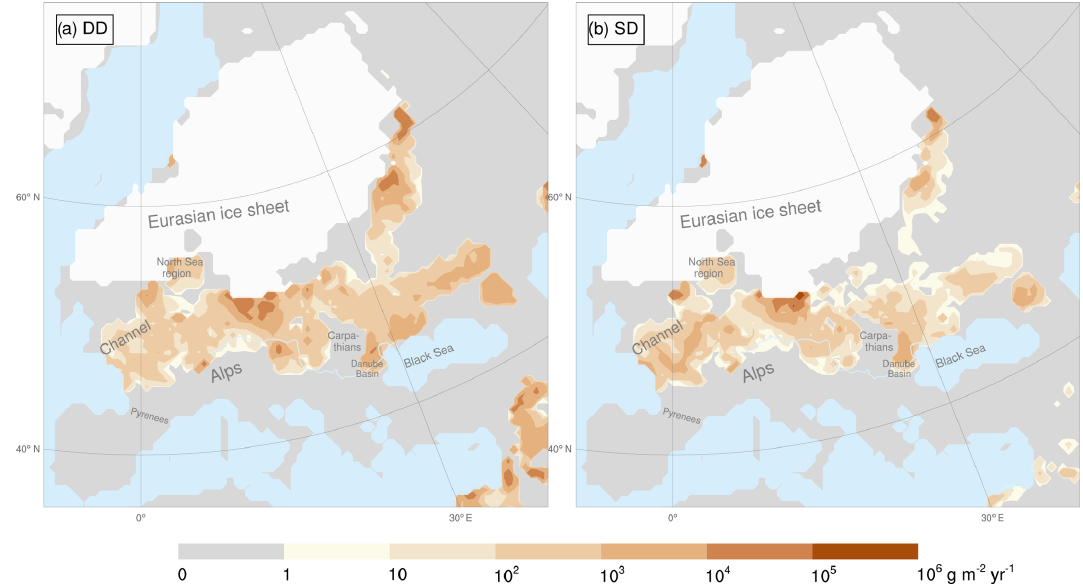
Figure 3. Dust emission rates for the Last Glacial Maximum. These reconstructions are based on (a) dynamic downscaling (DD) and (b) statistic dynamic downscaling (SD). Ice sheet extents (white overlay) and Danube (light-blue